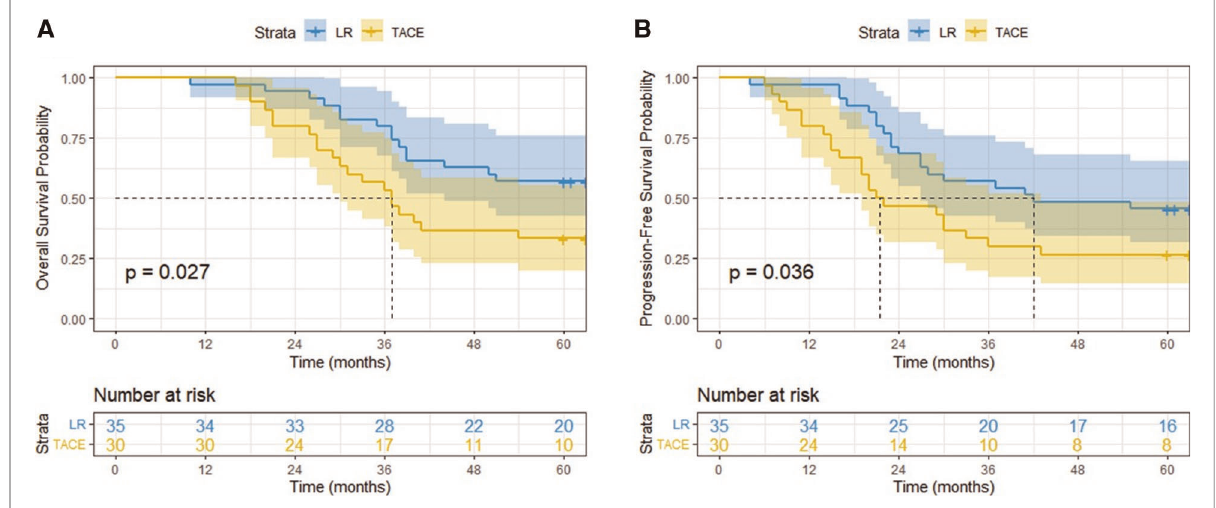
FIGURE 2 Overall survival ( A ) and progression-free survival ( B ) curves of patients with BCLC-B1 stage HCC treated by liver resection or transarterial